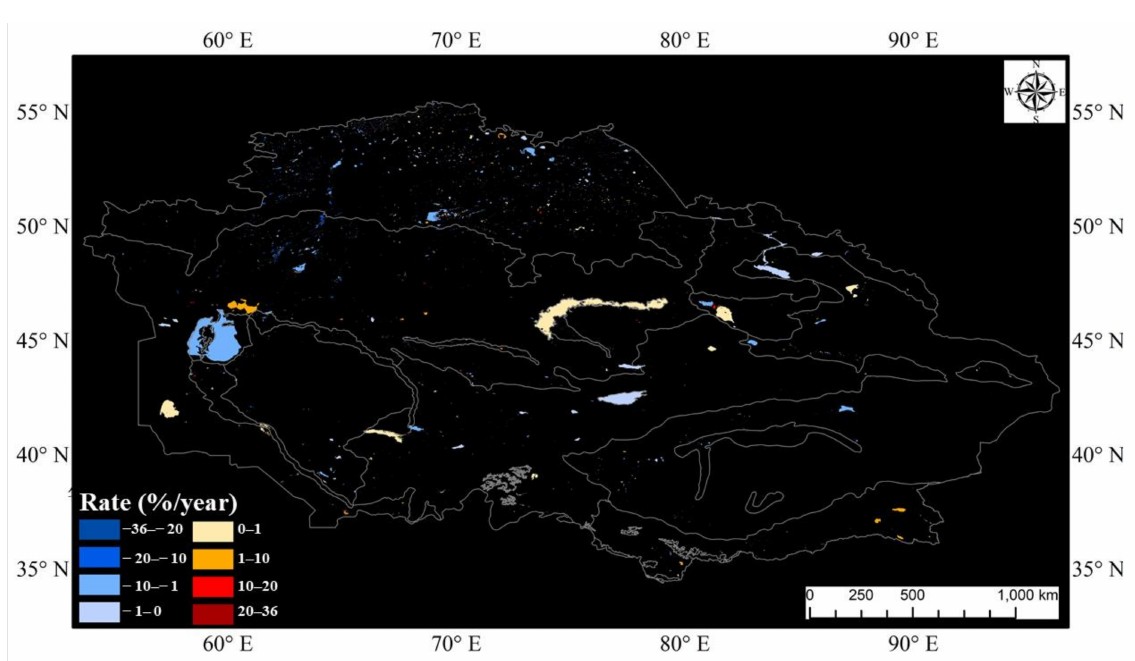
Figure 7. Spatial distribution of yearly change rate of each lake over seven terrestrial ecological zones in Central Asia as Figure